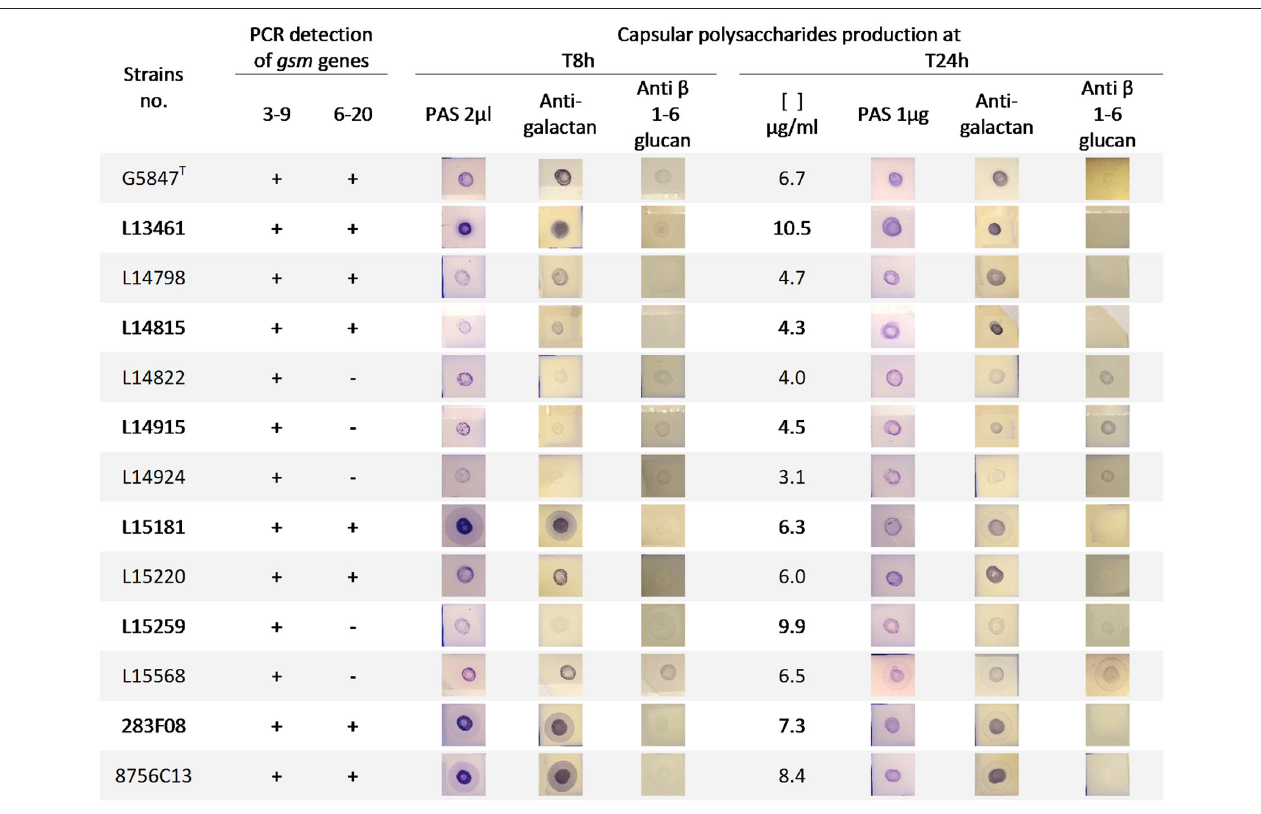
FIGURE 5 | Presence of gsm genes and capsular polysaccharides production in M. feriruminatoris isolates. Gsm genes identified in the type strain G5847, namely gsm3-9 and gsm6-20, were detected ( + ) or not ( − ) by two specific PCRs. Capsular polysaccharide (CPS) were purified from 8 to 24 h cultures and identified by dot-blots revealed by Periodic acid–Schiff (PAS) staining (general polysaccharides detection) and antisera targeting galactan and anti β -(1 → 6)-glucan. At 24 h, the purified CPS were further quantified ( µ g of glucose equivalent per ml of culture) and 1 µ g was deposited on the nitrocellulose